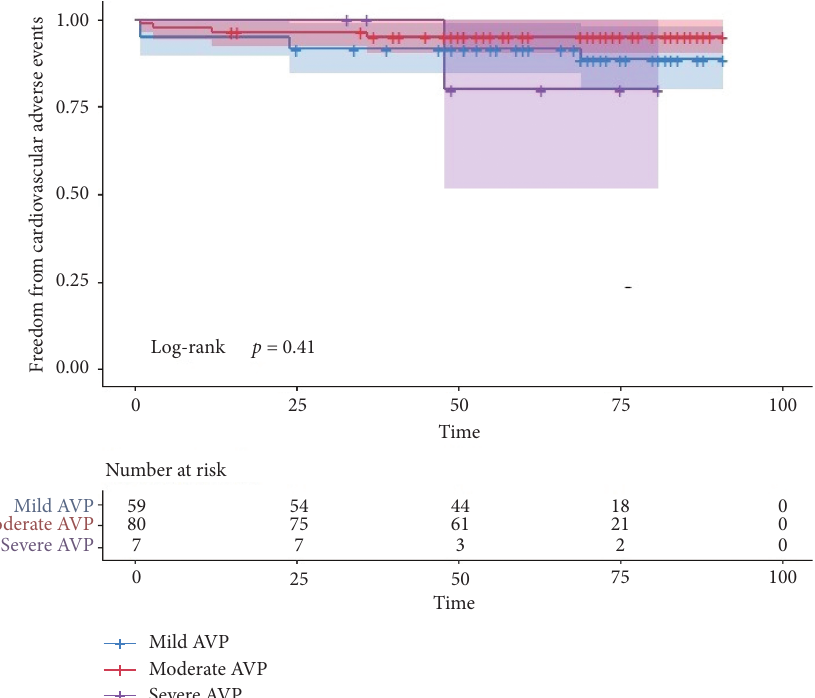
Figure 3: Survival rates without cardiovascular adverse events for 6 years among three degrees of aortic valve